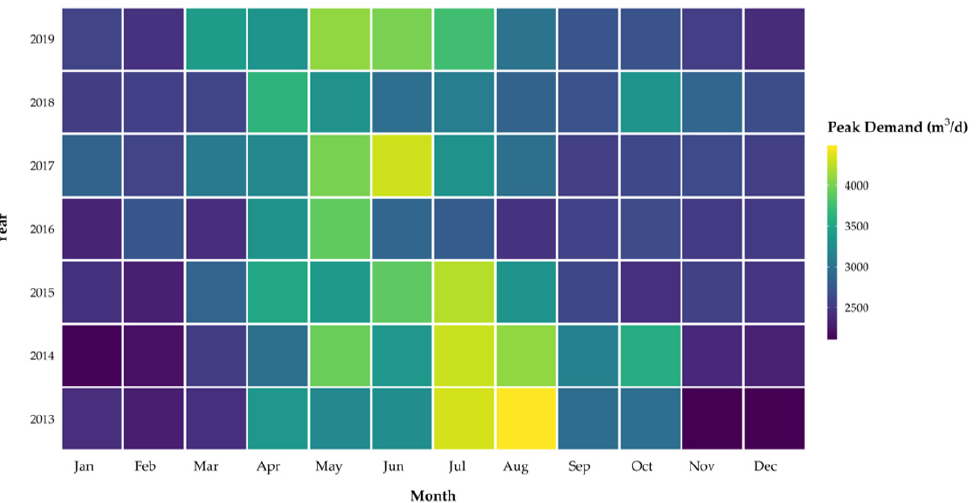
Figure 1. Maximum daily water demand per month for Zone 4. The lighter the color the higher the water demand.